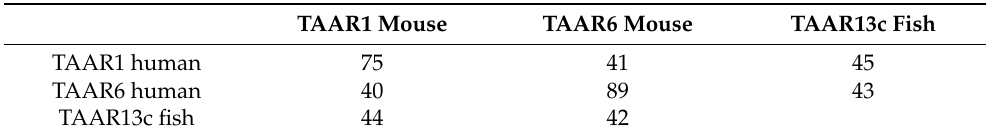
Table 3. Identity of human and mouse TAAR1 and TAAR6 receptors calculated using the BLAST program. TAAR1 Mouse TAAR6 Mouse TAAR13c Fish TAAR1 human TAAR6